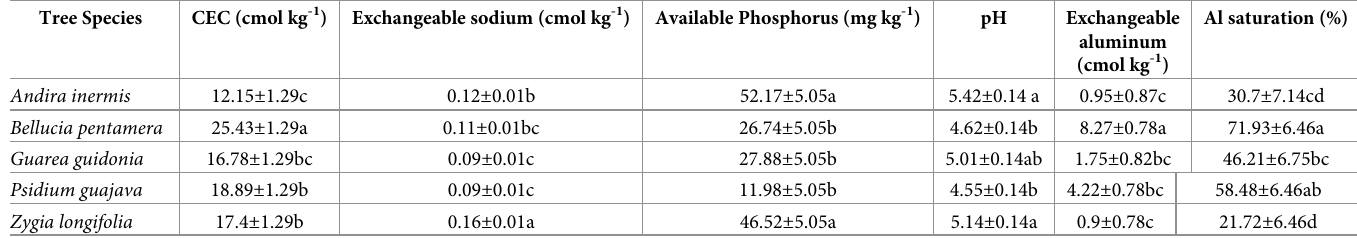
Table 2. Differences between tree species for the soil chemical variables (Mean ±